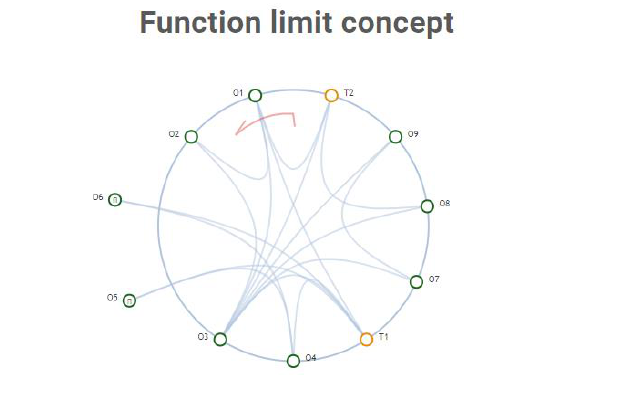
Fig. 1. Structure of a paragraph with mapped relationships between quanta